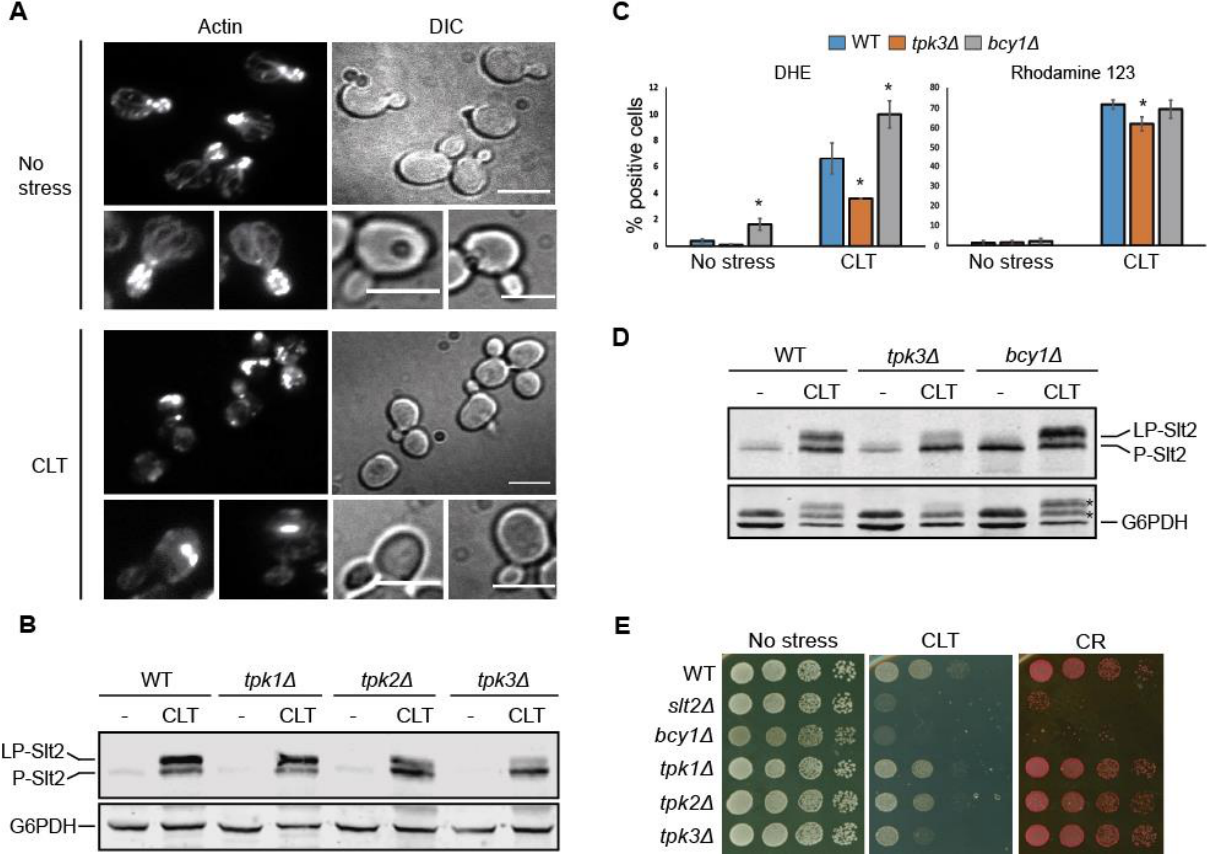
Figure 7. Involvement of the PKA kinase activity in clotrimazole-induced ROS production and Slt2 phosphorylation. ( A ) Rhodamine – phalloidin-based actin staining of BY4741 cells treated with 50 µg/mL of CLT or in basal conditions (no stress) for 4 h. Representative fluorescence and DIC photographs from three independent experiments are shown. Scale bar = 5 µm. ( B ) Western blotting analysis of the BY4741 (WT) strain and the indicated isogenic mutants. Cells were cultured without stimulus (-) or with 50 µg/mL of CLT for 4 h at 24 °C. Dually phosphorylated Slt2 and G6PDH (as a loading control) were detected with anti-phospho-p44/42 and anti-G6PDH, respectively. A representative blot from two independent experiments is shown. ( C ) Flow cytometry assay of the BY4741 (WT) strain and the isogenic tpk3Δ and byc1Δ mutants. Cells were either left untreated (no stress) or treated with 50 µg/mL of CLT for 4 h at 24 °C. Graphs represent the percentage of positive cells detected with flow cytometry that express a fluorescence signal for rhodamine 123 or dihydroethidium (DHE) fluorochromes. Data are presented as the mean of three independent experiments. Error bars indicate the standard deviation. Student’s t -test was calculated between the WT and mutant strains. * p -value < 0.05. ( D ) Western blotting analysis of the same samples as in ( C ). Proteins were detected as in ( B ). Asterisks in the lower panel showing G6PDH levels indicate bands that correspond to P-Slt2 and LP-Slt2. ( E ) Sensitivity of BY4741 slt2Δ and the same strains as in ( B,D ) to CLT and CR per the drop dilution growth assay. Ten-fold serial dilutions of cell suspensions were spotted onto YPD plates in the absence (no stress) or presence of 1 µg/mL of CLT or 30 µg/mL of CR and incubated at 30 °C for 72 h. A representative assay from two independent experiments is shown.